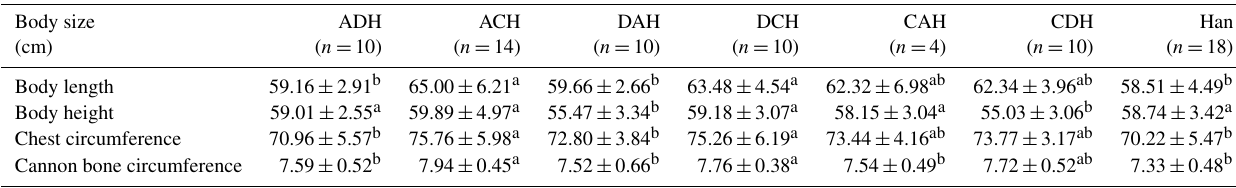
Table A3. The result of variance analysis of body size parameters of three-way crossbred and Han lambs at 3 months of age (mean ± standard deviation).